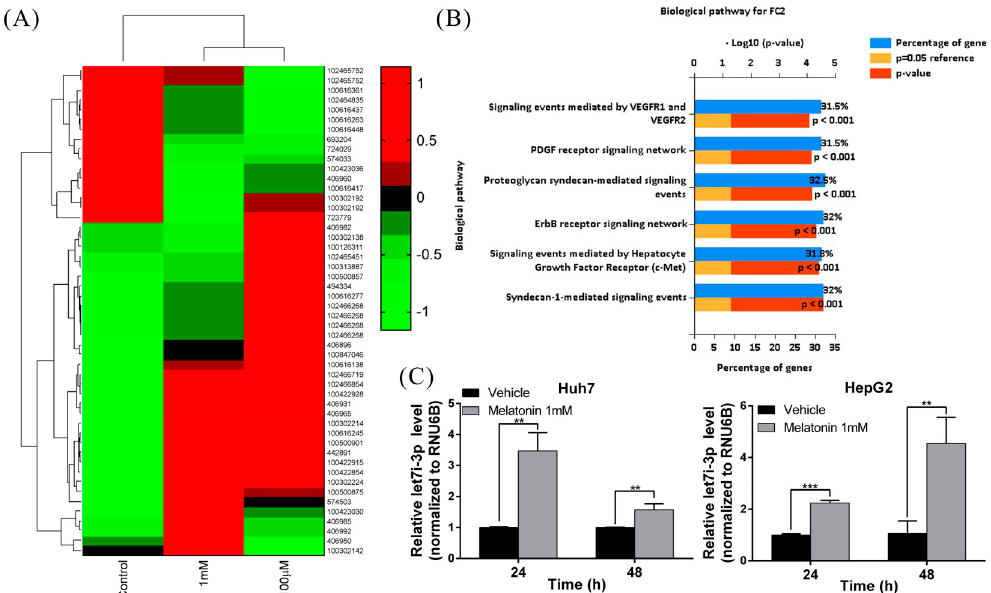
Figure 2. Melatonin induces let7i-3p expression in HCC cells. ( A ) Results of heatmap analysis illustrating miRNA expression profiles in Huh7 cells treated with/without melatonin. ( B ) Bar charts representing the enriched biological pathways associated with the differentially-expressed genes after melatonin treatment. ( C ) Real-time RT-PCR results showing the let7i-3p level after melatonin treatment. RNU6B served as the internal control. Data are expressed as means ± SD of three independent experiments; ** p < 0.01, *** p < 0.001.